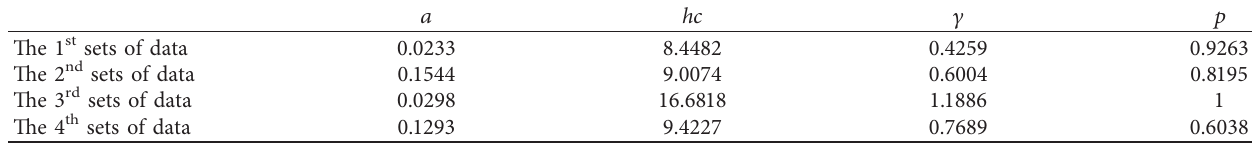
Table 6: Fitting parameters in every sets of data.